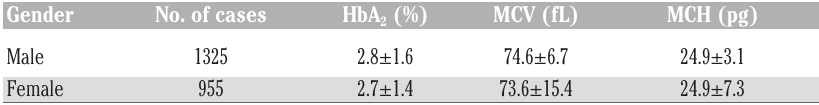
Table 1. Hemoglobin A , mean cell volume and mean cell hemoglobin values of males and 2 females with normal b -globin gene sequence in Eastern Indian Population (N=2280). Gender